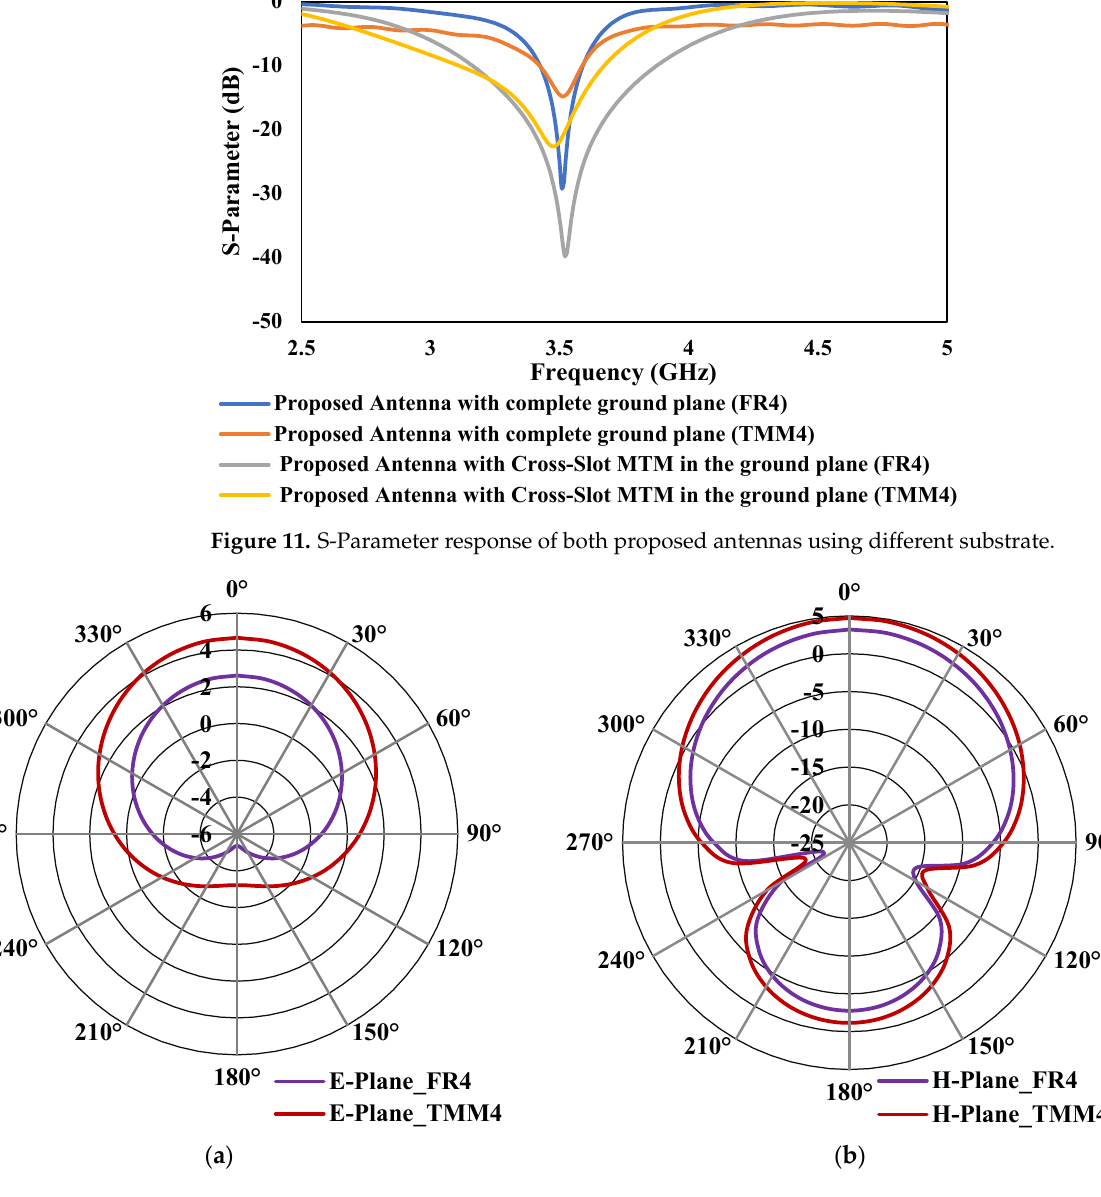
Figure 12. Simulated radiation pattern of the proposed antenna with a complete ground plane at 3.5 GHz ( a ) E-plane ( b ) H-plane.